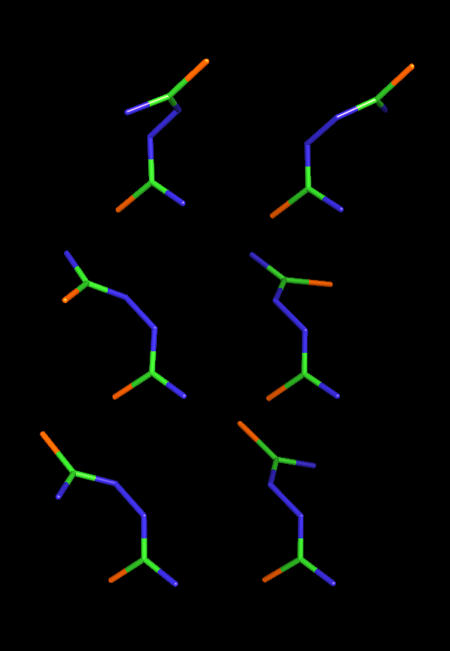
Six different local minimum conformations of dithiobiurea generated by the normal-mode-analysis–monitored energy minimization procedure.The carbon, nitrogen, and sulfur atoms are green, blue, and orange, respectively.